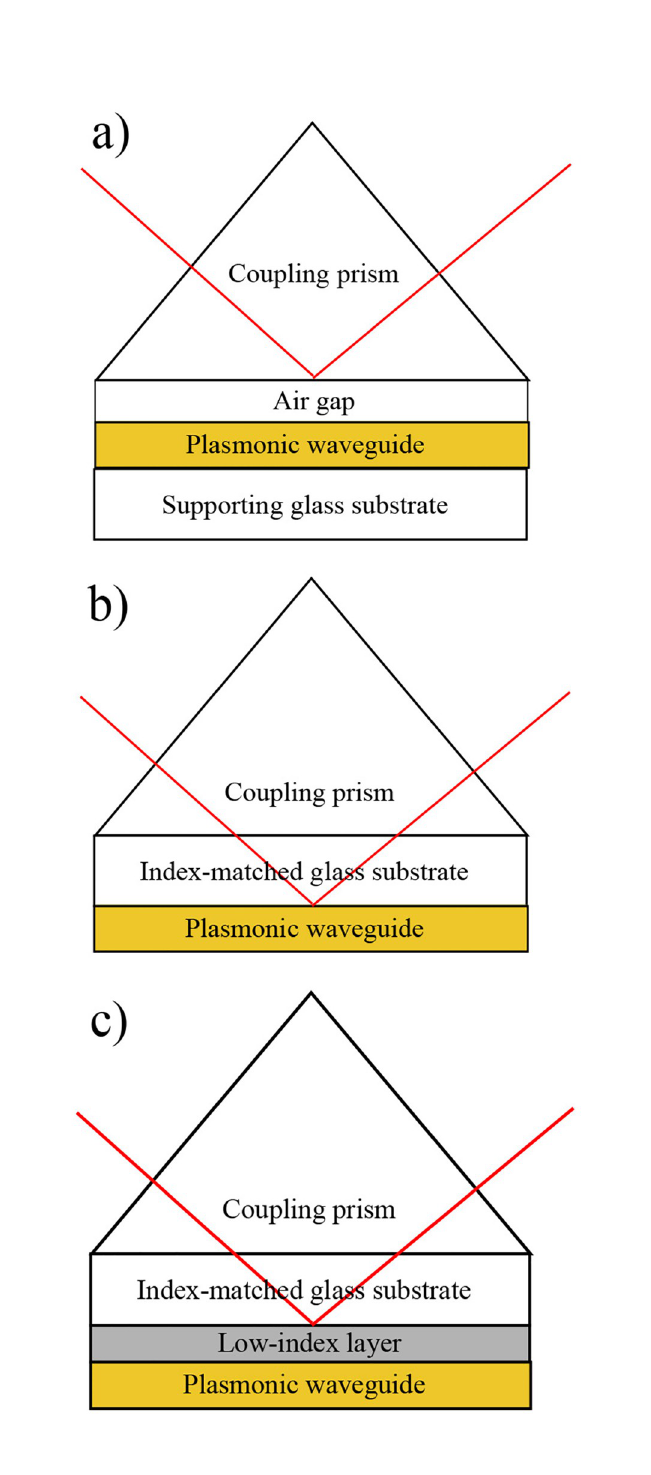
Fig 1. Schematic representations of attenuated total reflection. a) the Otto configuration; b) the Kretschmann configuration; c) the Kretschmann configuration with the addition of a low-index coupling layer, as reported here.